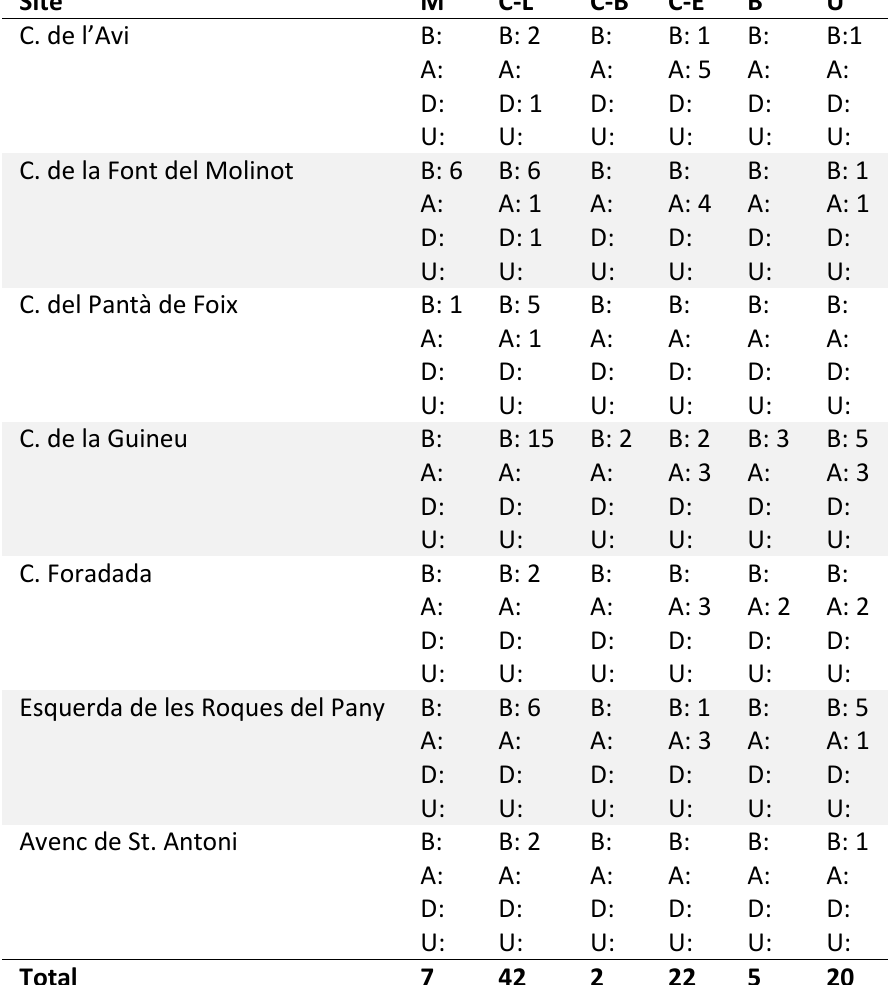
Table 4. Distribution of large blades, arrowheads and daggers according to raw materials. Abbreviations: Marine (M). Continental lacustrine (C-L). Continental brecciated (C-B). Continental evaporitic (C-E). Burned (B). Unidentified (U). Y axis: Blade or blade fragment (B). Arrowhead (A). Dagger (D). Unidentified (U) Site M C-L C-B C-E B